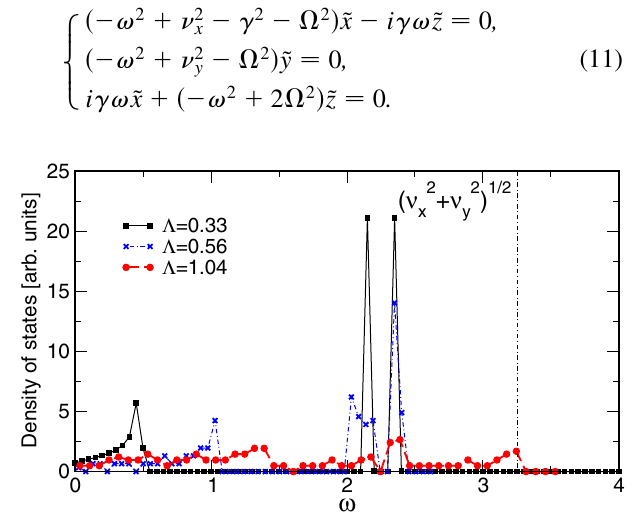
FIG. 1. (Color) Dispersion function evaluated under the smooth approximation of three 1D crystalline beams with (cid:2) (cid:2) 0 : 33 , FIG. 2. (Color) Density of states corresponding to Fig. 1 eval- uated under the smooth approximation at three beam densities with (cid:2) (cid:2) 0 : 33 , 0 : 56 , and 1 : 04